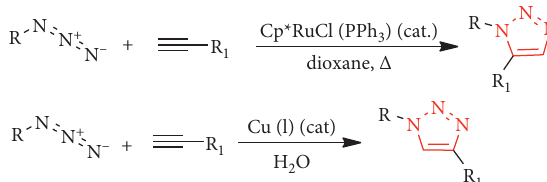
Scheme 4: Thermal reactions and mixtures in both 1,4- and 1,5- substituted regioisomers.